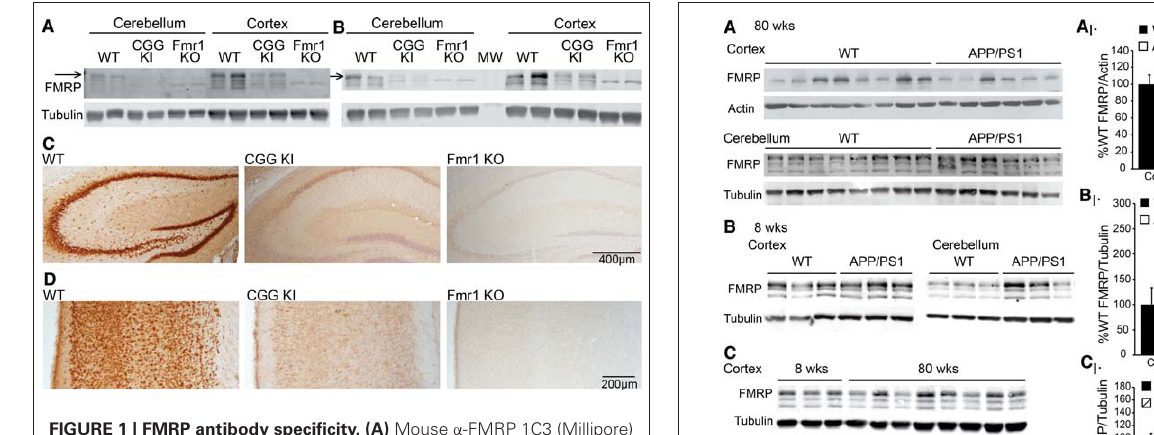
FIGURE 1 | FMRP antibody specificity. (A) Mouse α -FMRP 1C3 (Millipore) 1:250 on cerebellar and combined cerebral cortex and subcortical brain lysates of WT ( n = 2), premutation model CGG KI ( n = 2), and Fmr1 KO mice ( n = 2). Arrow indicates the FMRP-specific band which is absent in Fmr1 KO lysates. (B) Rabbit α -FMRP 17722 (Abcam) 1:1000 on the same brain lysates as in (A) . (C) Immunohistochemistry with the 17722 α -FMRP antibody in WT ( n = 3), CGG KI ( n = 3) and Fmr1 KO ( n = 4) hippocampus. (D) Cortical FMRP expression from identical animals as in (C) stained with